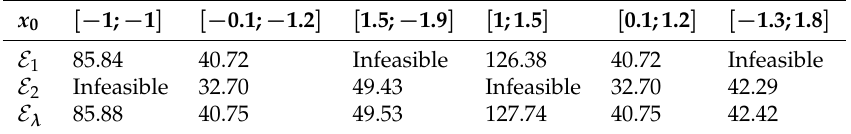
Table 2. Cost comparison between various terminal sets for given six different initial states.